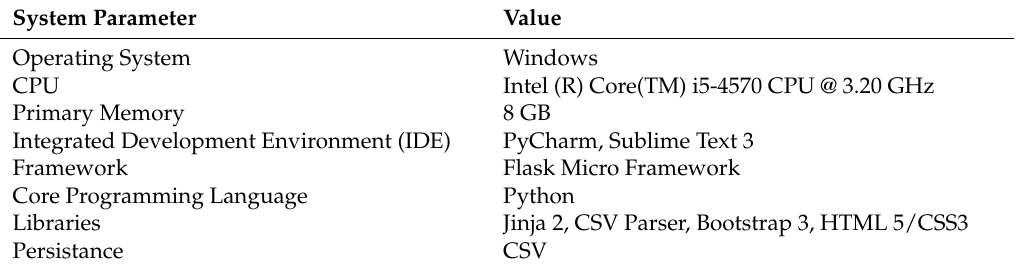
Table 2. Specification of implementation environment of general purpose